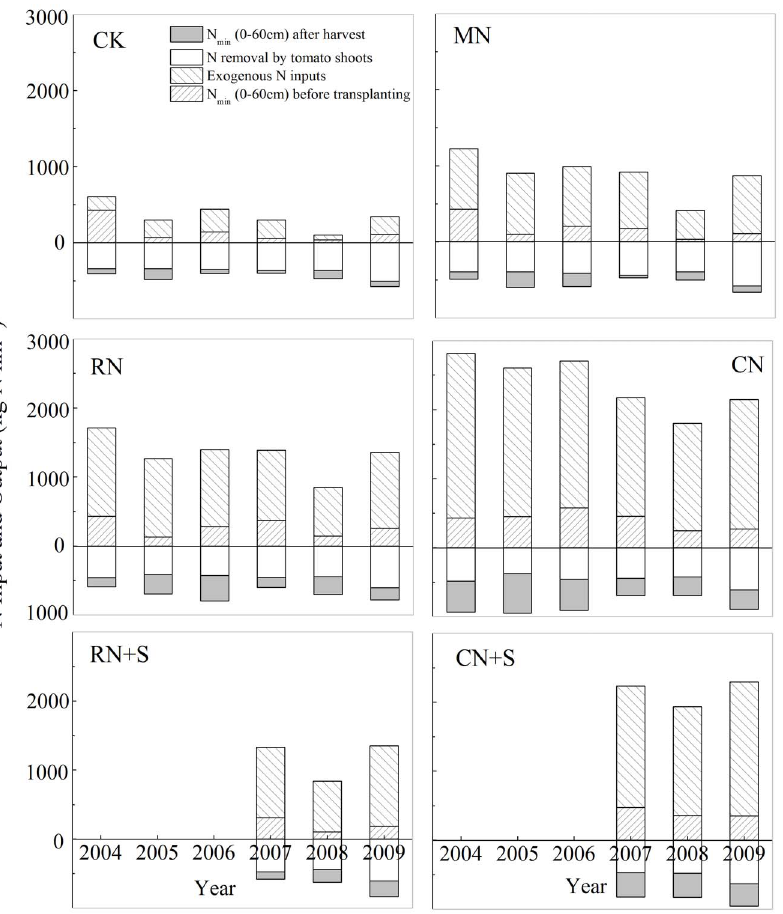
Figure 4. Apparent N loss with different treatments in the year-round greenhouse tomato planting system from 2004 to 2009 in Shouguang, northern China.